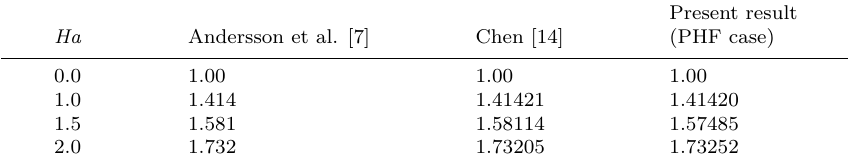
Table 2. Comparison of skin-friction coefficient for PST case (Newtonian fluid). λ Nazar et al.